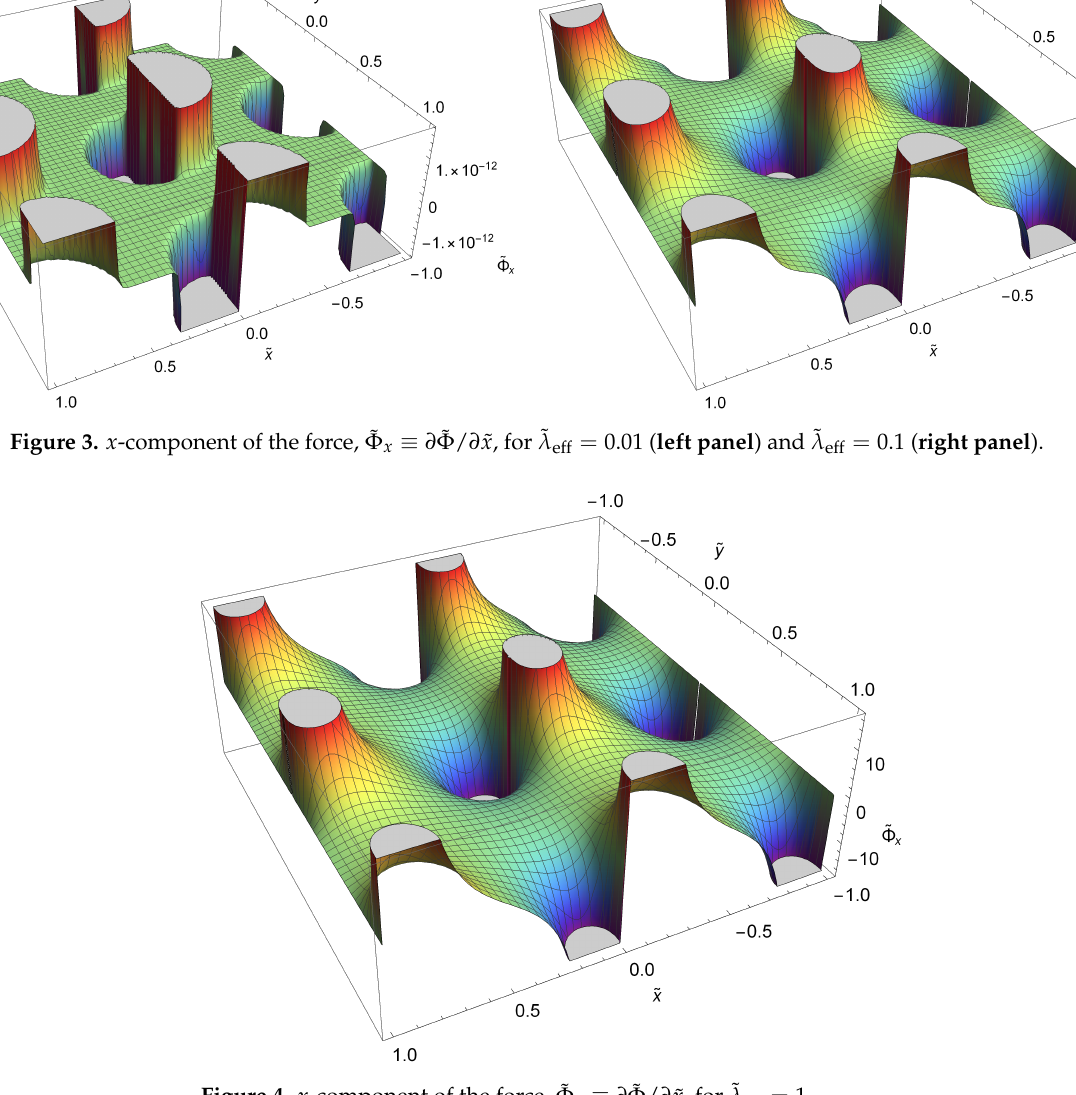
Figure 4. x -component of the force, ˜ Φ x ≡ ∂ ˜ Φ / ∂ ˜ x , for ˜ λ eff =